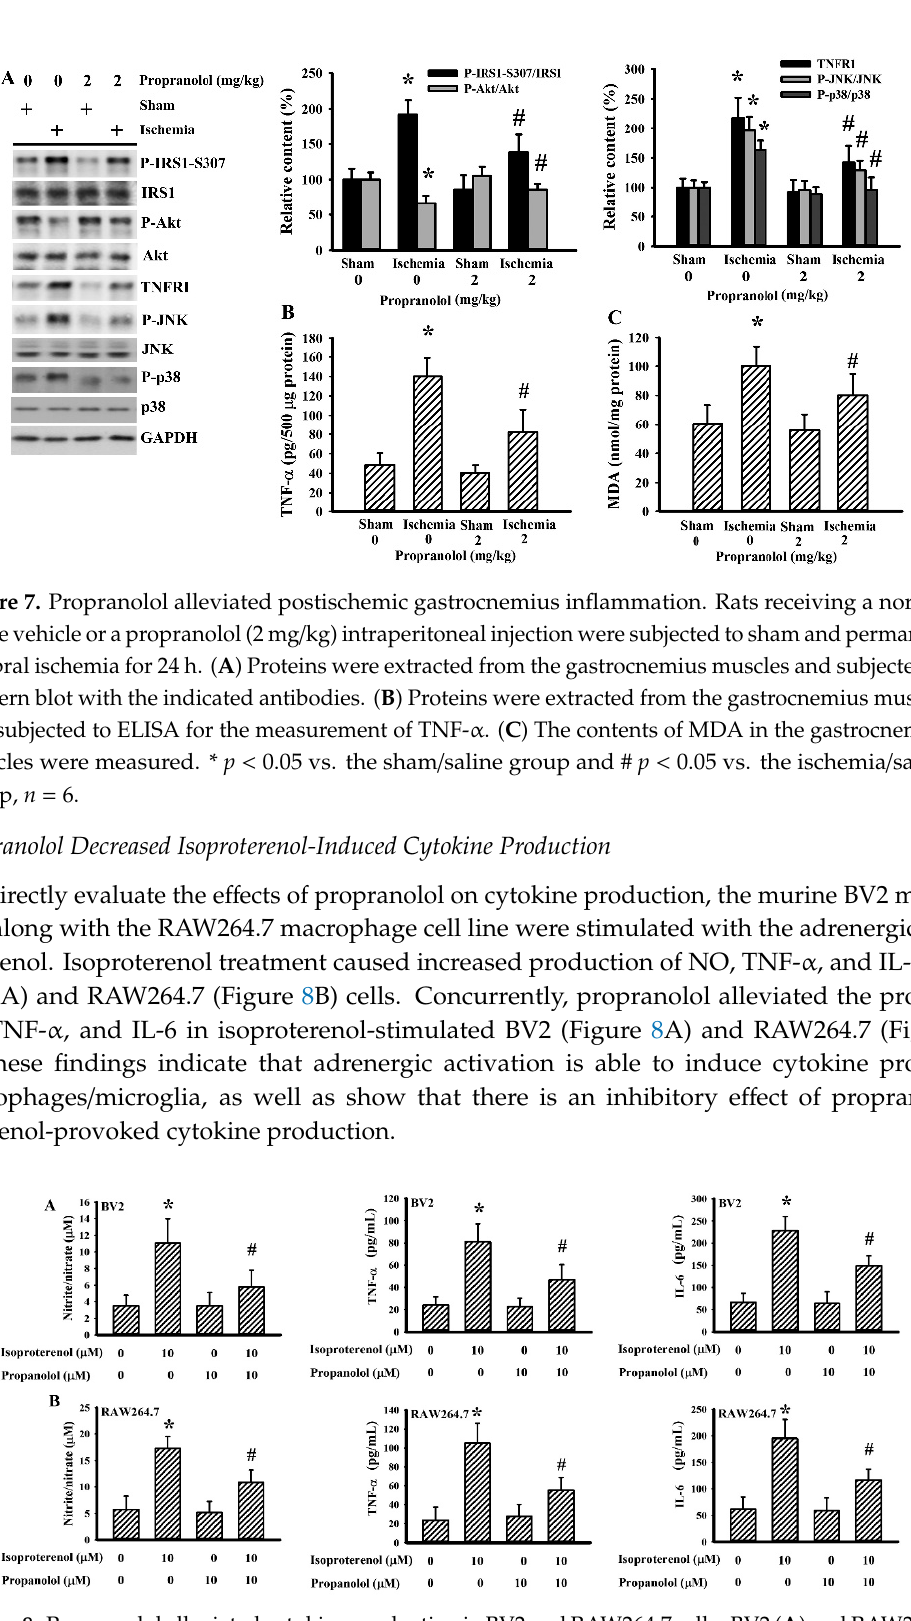
Figure8. PropranololalleviatedcytokineproductioninBV2andRAW264.7cells. BV2( A )andRAW264.7 ( B ) cells were pretreated with a vehicle or propranolol (10 µ M) for 30 min before being incubated with isoproterenol (0 and 10 µ M) for an additional 24 h. Supernatants were collected and subjected to a Griess reagent or ELISA for the measurement of nitric oxide (NO), TNF- α , and interleukin-6 (IL-6). * p < 0.05 vs. untreated control and # p < 0.05 vs. isoproterenol control, n =